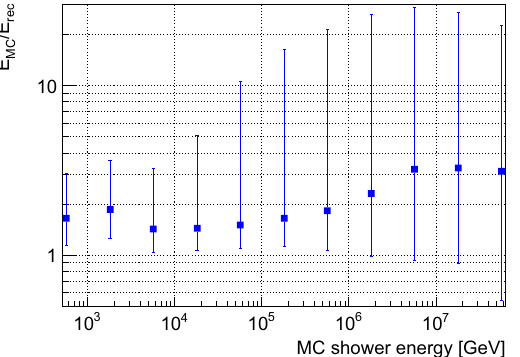
Fig. 1 Left angular error of the direction reconstruction for shower- like neutrino events as a function of the MC shower energy. Right the ratio of the MC and the reconstructed shower energy, as a function of